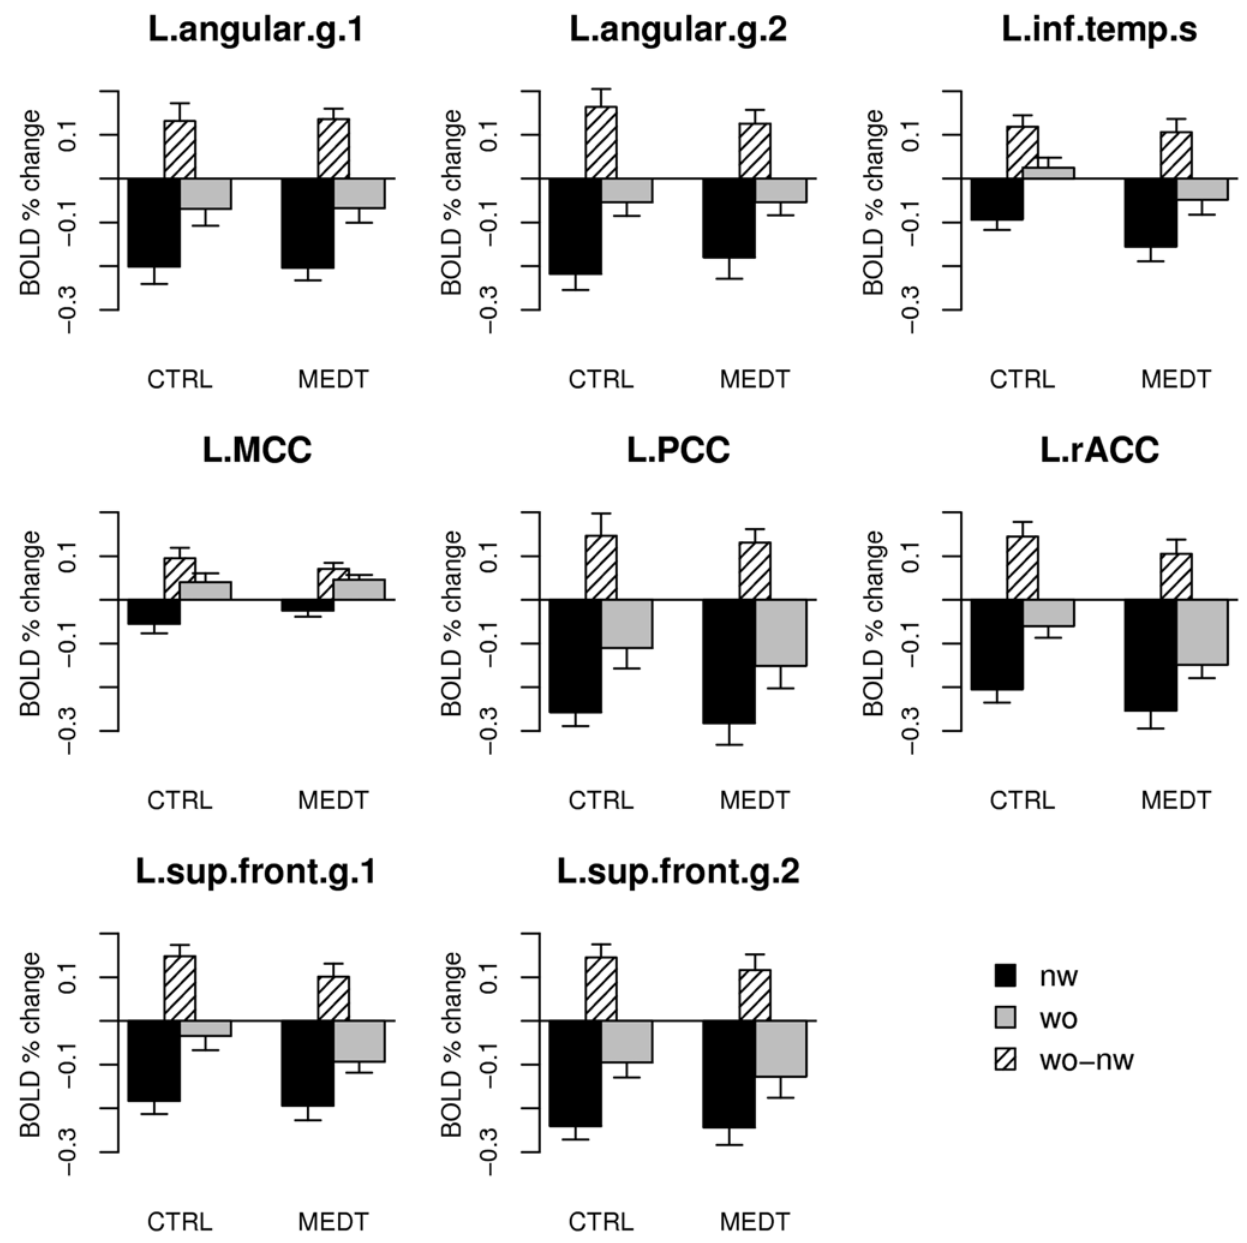
Figure 2. ROI-based averages of the Gamma model beta coefficients for words (‘‘wo’’) and nonwords (‘‘nw’’) in controls (CTRL) and meditators (MEDT). Abbreviations for ROI names are the same as in Table 2, where the index 1 and 2 for clusters with the same anatomical label follows the order in the table.